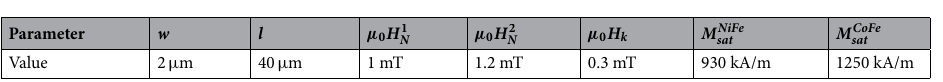
Table 1. Input parameters used for analytic